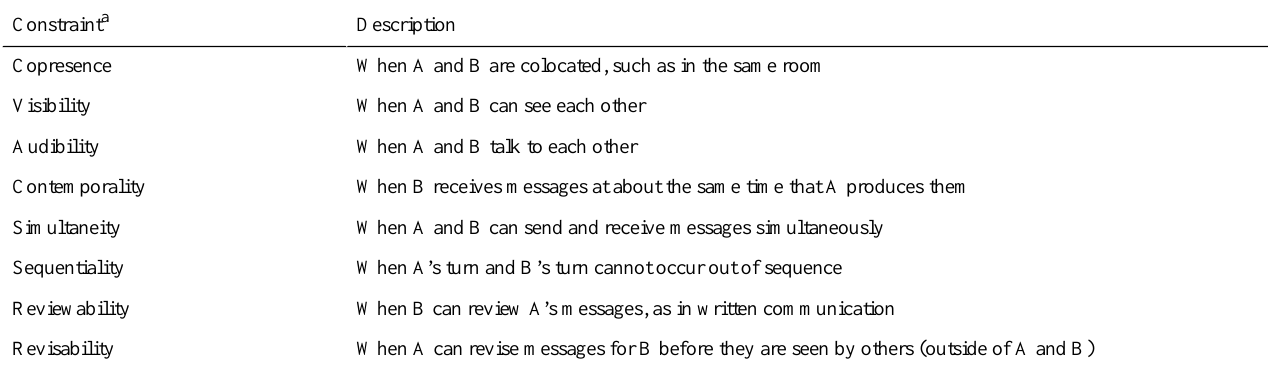
Table 1. Constraints on